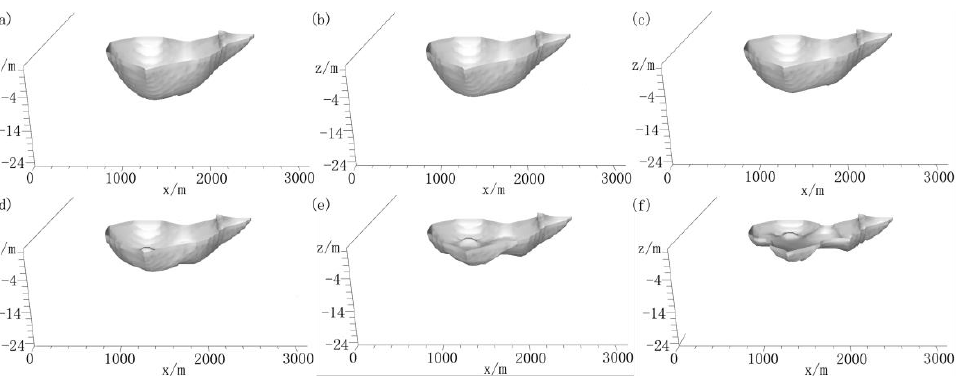
Figure 10. Freshwater lenses under different impermeable surface areas. ( a – f ) the impermeable surface areas are 0.084, 0.189, 0.336, 0.525, 0.756 and 1.029 km 2 , respectively.